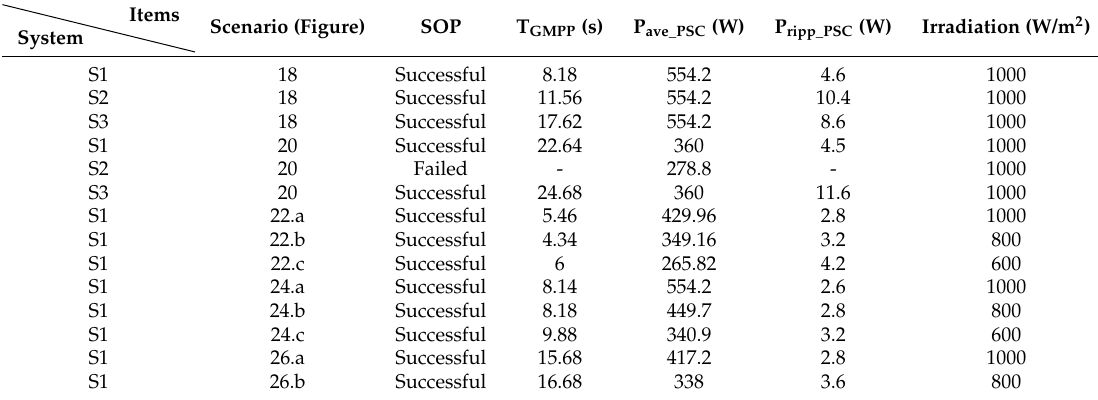
Table 2. The experimental